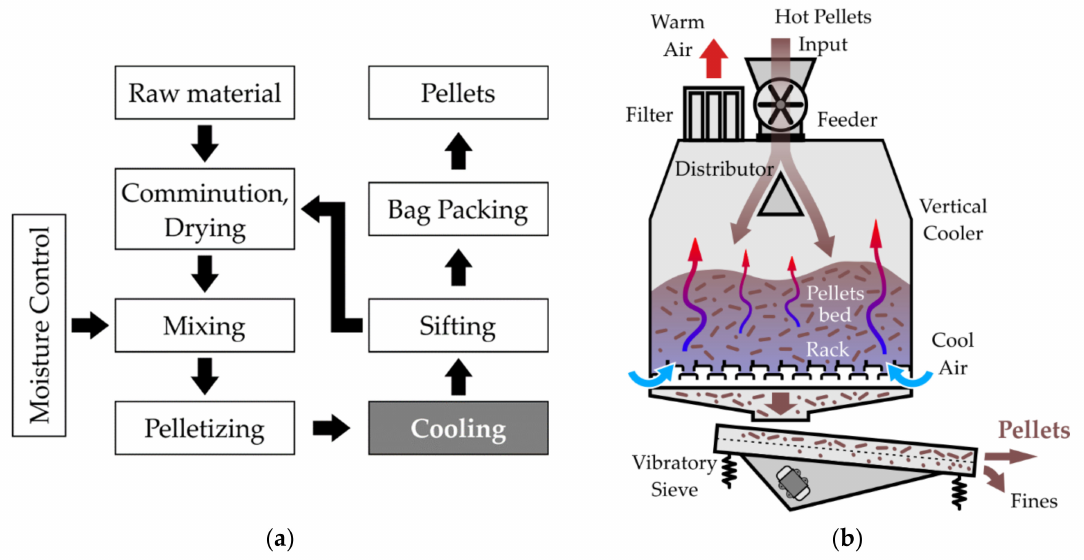
Figure 1. Pellets production and cooling: ( a ) pellets production process scheme; ( b ) counterflow pellet cooling